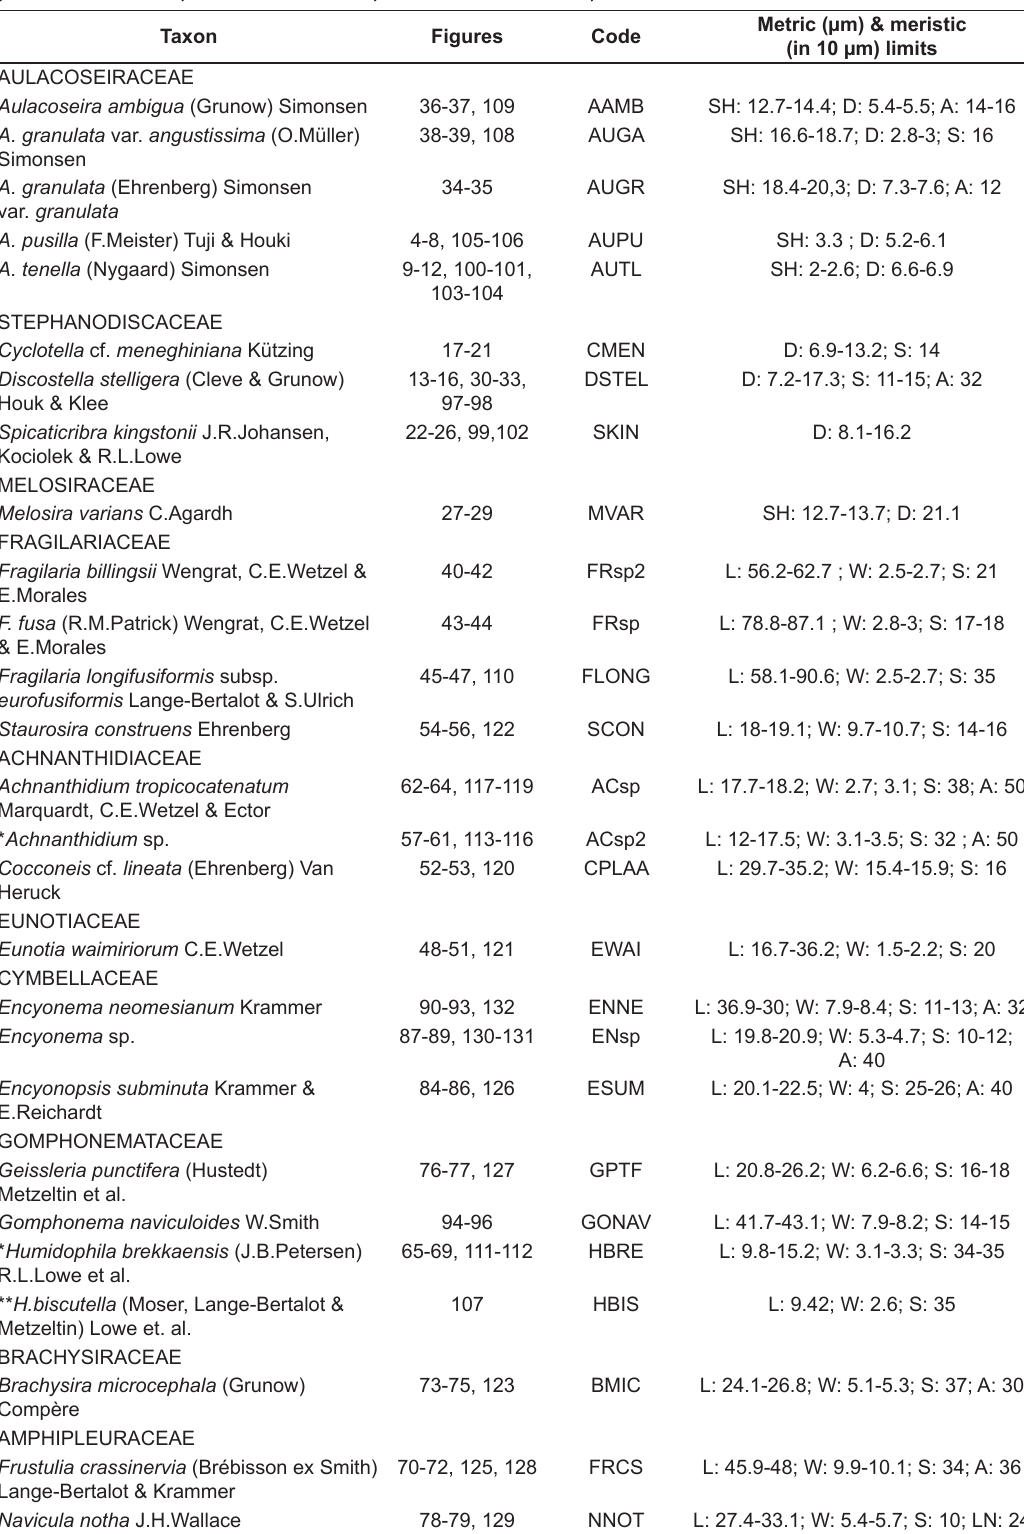
Table 2. List of diatom taxa identified from the reservoirs (>2% relative abundance). Morphometric and meristic limits and ecology according to the literature. D: diameter (μm); L: length (μm); W: width (μm); SH: semi cell height (μm); S: striae in 10 μm; A: areolae in 10 μm; LN: lineolae in 10